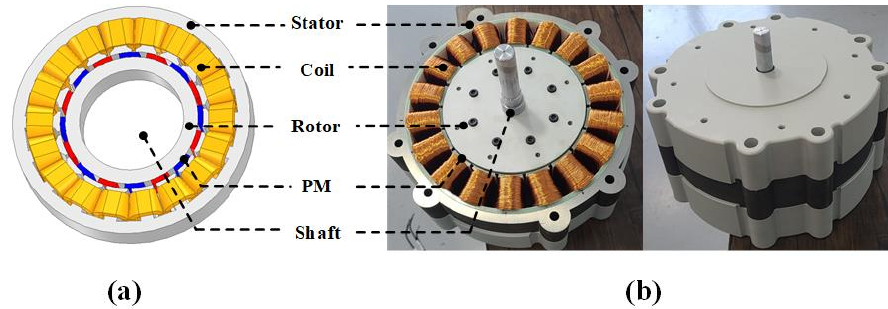
Figure 11. Analysis model: ( a ) FEM analysis model and ( b ) actual model. Table 4. Specifications of the actual PMSG.